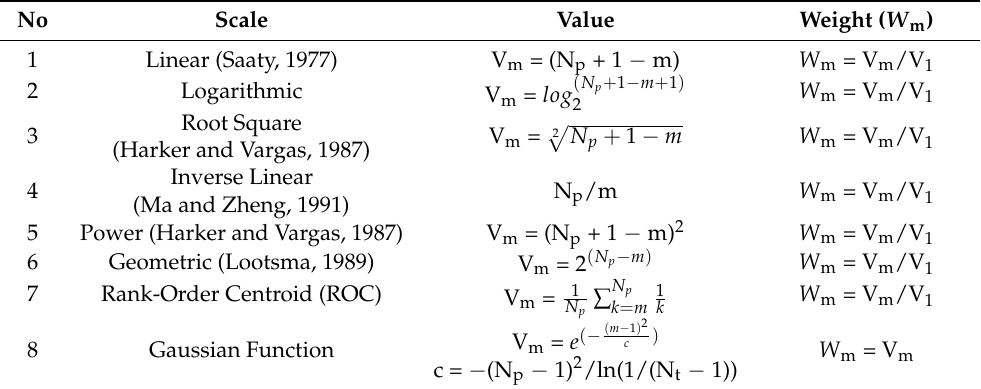
Table 2. Weight of different